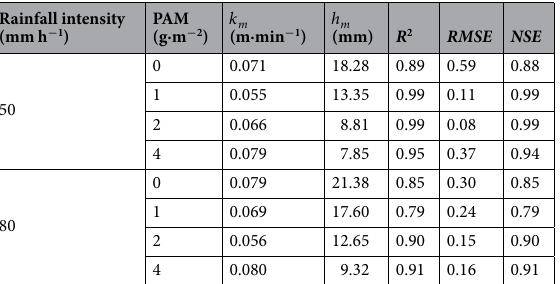
Rainfall intensity (mm h − 1 )